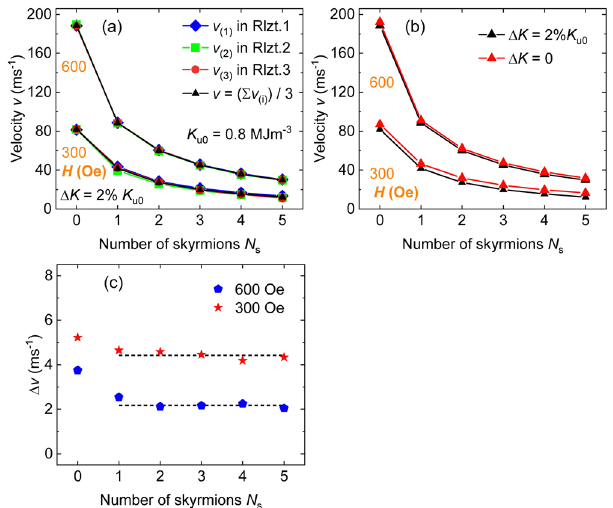
Fig. 6 Comparison of ensemble velocity evolution with the number of skyrmions in clean and granular nanotracks. a Ensemble velocity versus the number of skyrmions N s for the granular nanotrack at two various fi eld strengths ( H = 300Oe and 600Oe). For each fi eld strength, three different realizations (Rlzts.1 ‒ 3) of grain distribution are considered. Black triangles are the average value of v (1) , v (2) , and v (3) , the ensemble velocities in the three different realizations of grain distribution. b Ensemble velocity versus N s for the clean ( Δ K = 0, where Δ K represents the deviation of perpendicular magnetic anisotropy strength from its average value K u0 ) and granular ( Δ K = 2% K u0 ) nanotracks. c Difference of the ensemble velocities in the clean and granular nanotracks (de fi ned as Δ v = v (clean) – v (granular) ) against N s , which are derived from panel b. Lines are guides to eyes. K u0 = 0.8 MJm − 3 and Dzyaloshinskii-Moriya interaction strength D = 3.5 mJm − 2